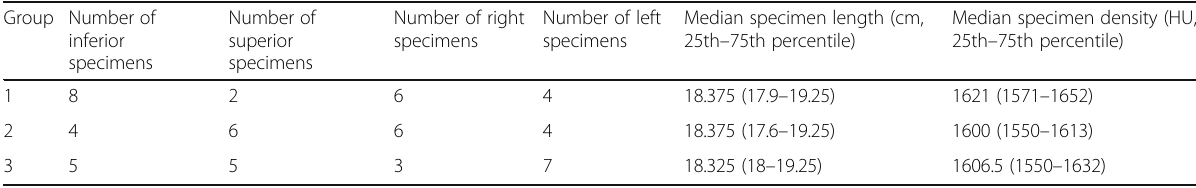
Table 2 Baseline characteristics of the experimental specimens Number of Group Number of inferior specimens